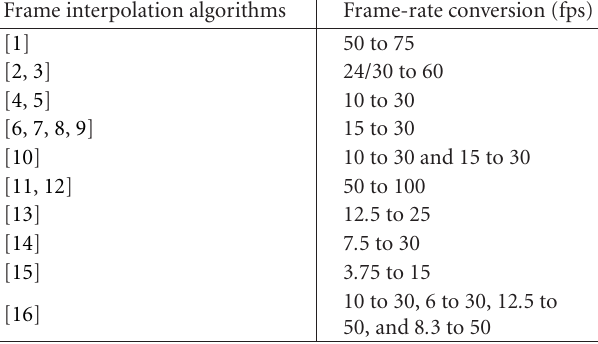
Table 1: Frame rates for frame interpolation. Frame interpolation